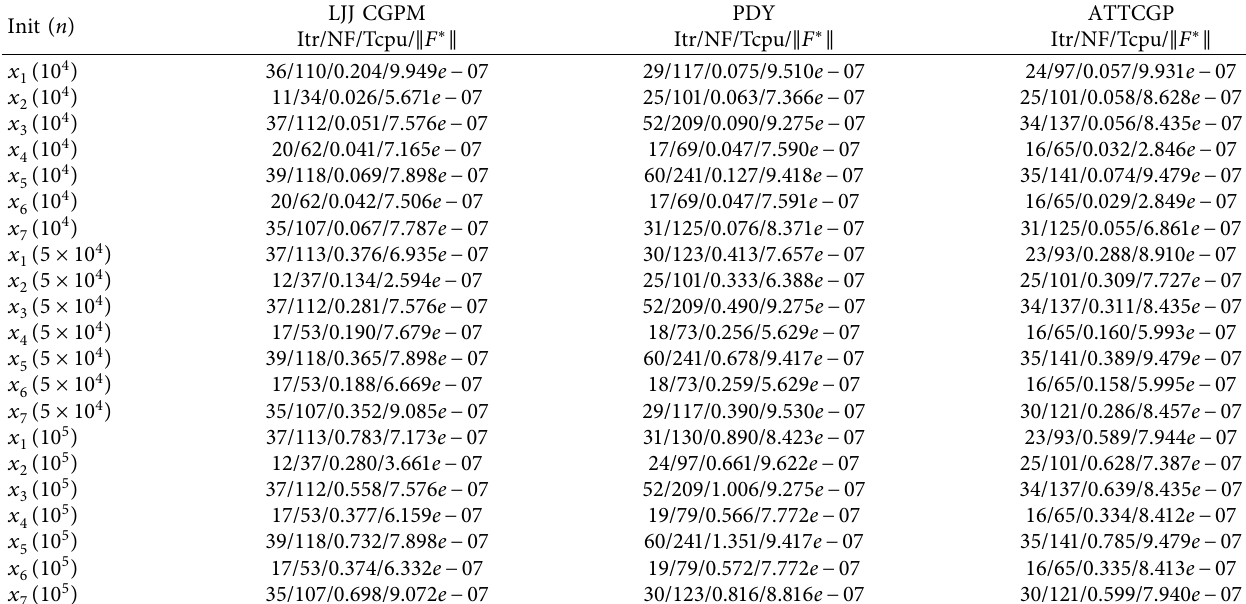
Table 6: Numerical results on Problem 6.